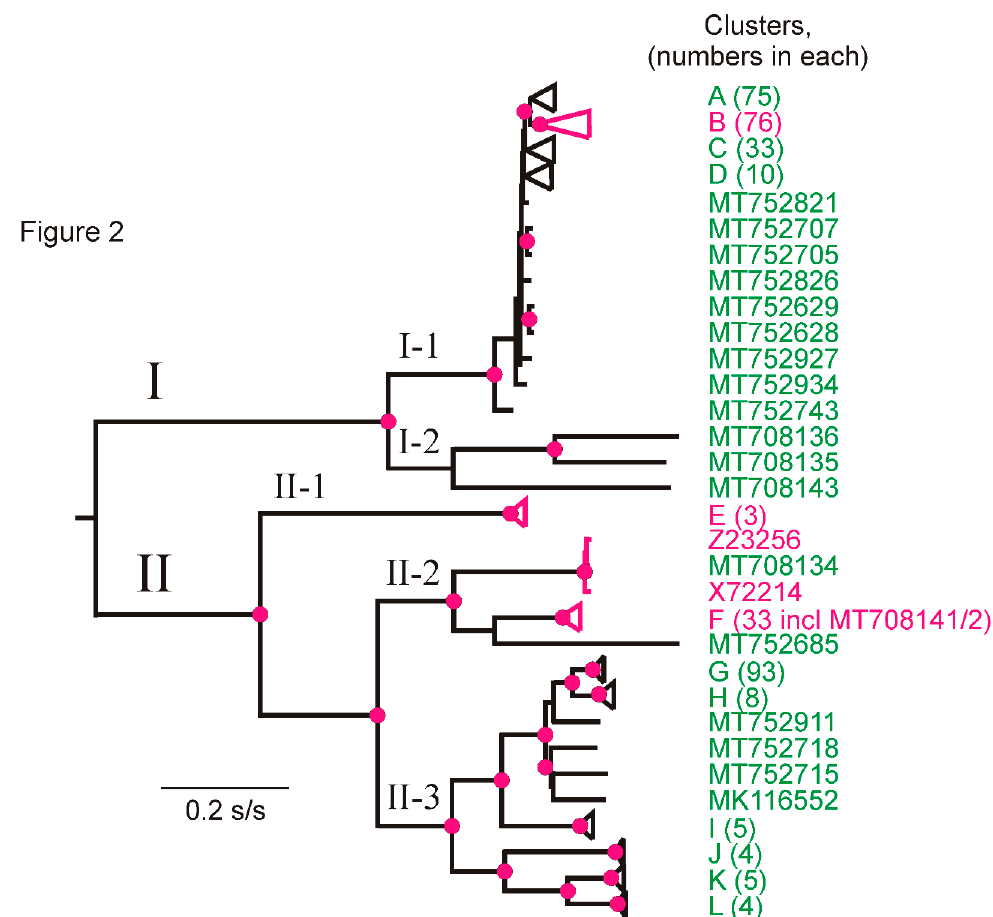
Figure 2. A Maximum Likelihood phylogeny of the 370 non-rec potato virus X concats. The phylogroups and minor phylogroups have Latin-Arabic numbers, and the clusters (SM File S2) have a capital letter, and in brackets next to them, the number of isolates within each. The Accession Codes of singletons are shown. Singletons or clusters of isolates only from South America, mostly Peru, are green, whereas singletons from other regions of the world, or clusters containing such isolates, are in red. All details are given in SM File S1. Red disks mark the nodes with >0.95 SH support. Scale bar: s/s means substitutions/site. SM File S2 shows the Accession Codes of the isolates in the different clusters shown in this figure.